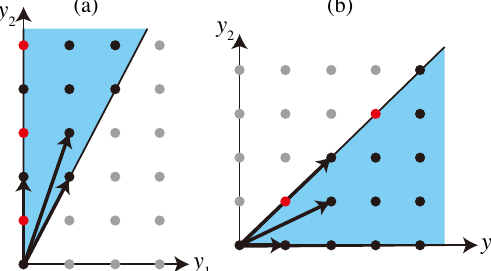
FIG. 10. Example of equivalent SGs. (a) SG 199. (b) SG 208. The polyhedral cone Y ’ s are represented by the shaded area, the ¯ X generators of are represented by the bold black arrows, the points in Z 2 ∩ Y are represented by black dots, and the points in Z 2 ∩ Y − ¯ X are represented by red dots. The transformation F ¼ ¯ X ¯ X in SG 208 to the Y and in SG ð 1 2 − 1 − 1 Þ transforms Y and